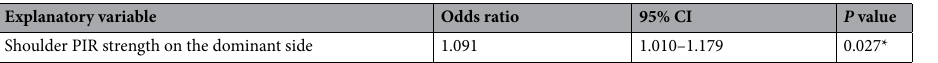
Table 3. Results of logistic regression analysis. CI, confidence interval; PIR, prone internal rotation. * P < 0.05.